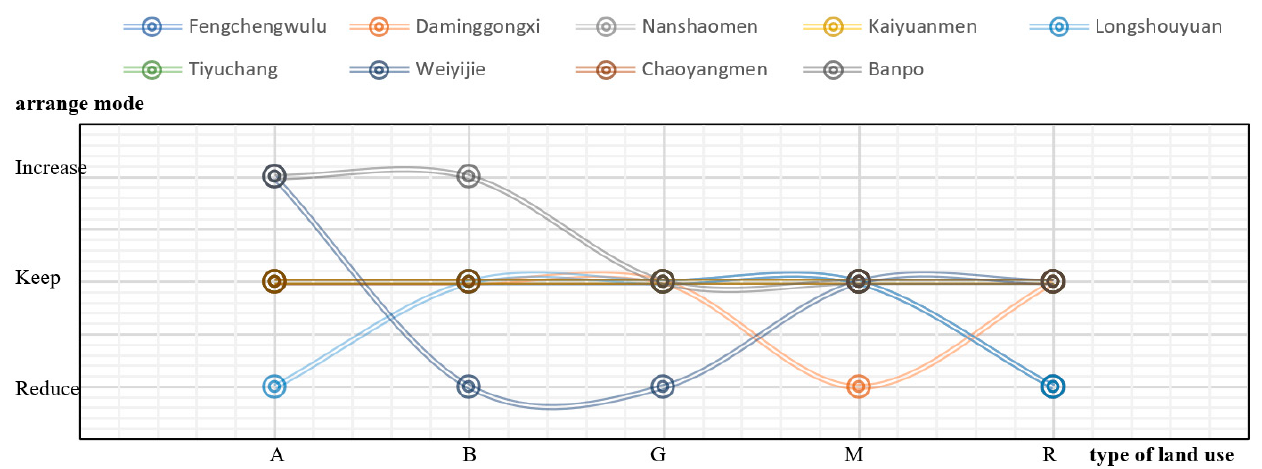
Figure 6. Areas with high development intensity; diagram of the optimization plan for the develop- ment intensity of each station.